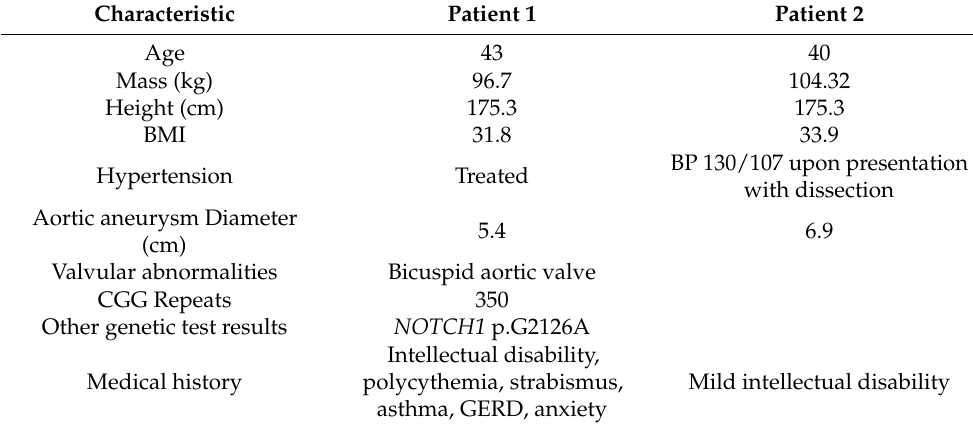
Table 1. Patient